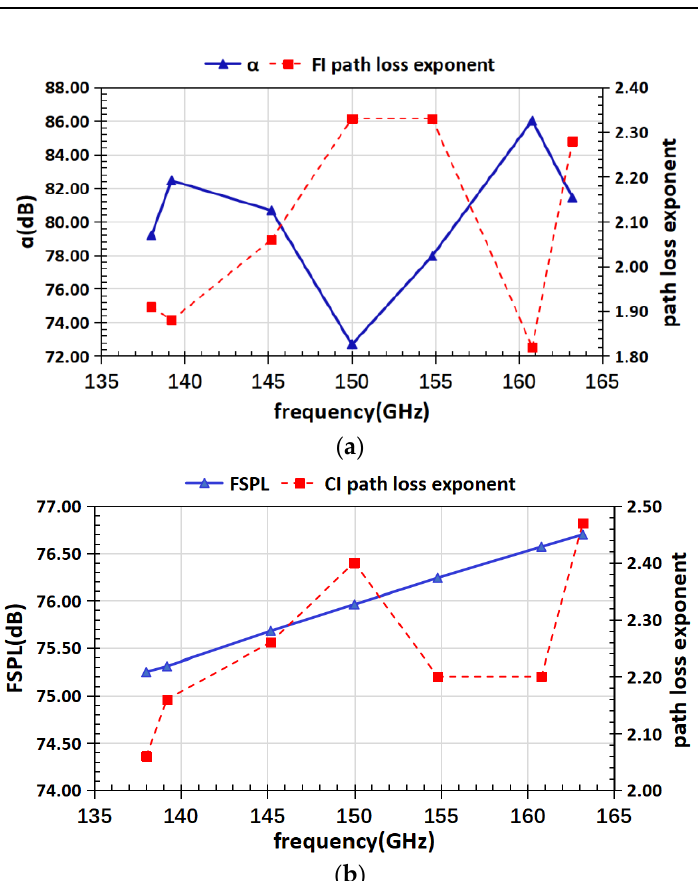
Figure 7. ( a ) FI model path loss model parameters; ( b ) CI model path loss model parameters.